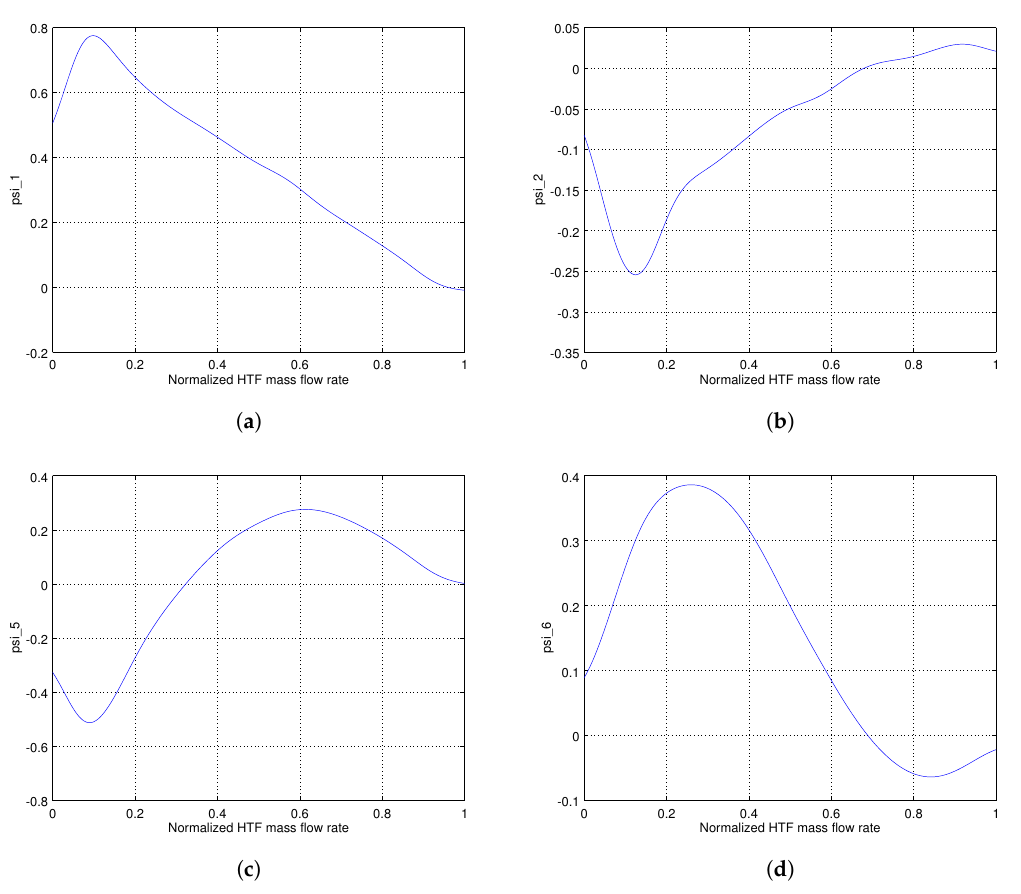
Figure 2. RBF network output examples as a function of normalized HTF mass flow rate. ( a ) ψ 1 ; ( b ) ψ 2 ; ( c ) ψ 5 ; and ( d ) ψ 6